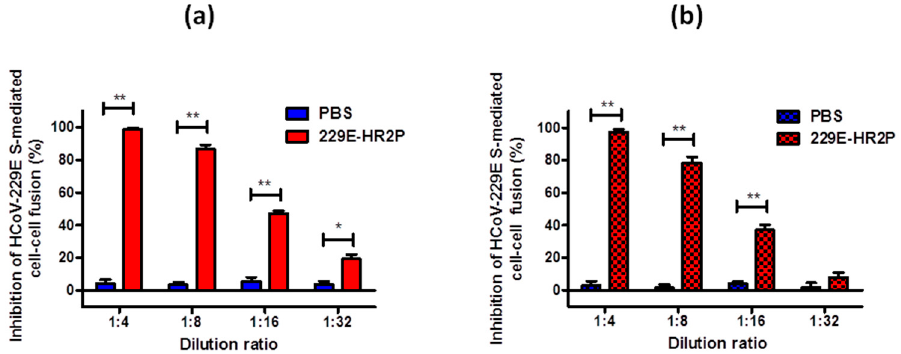
Figure 7. Inhibitory activity of 229E-HR2P in mouse upper and lower respiratory tracts against HCoV-229E S-mediated cell-cell fusion. ( a ) Fusion inhibitory activity of upper respiratory tract lavage fluid of mice treated with or without 229E-HR2P; ( b ) Fusion inhibitory activity of lower respiratory tract lavage fluid of mice treated with or without 229E-HR2P. Data are means ± SD of triplicate samples from a representative experiment. The asterisks represent significant differences: ** p < 0.01; * p < 0.05.